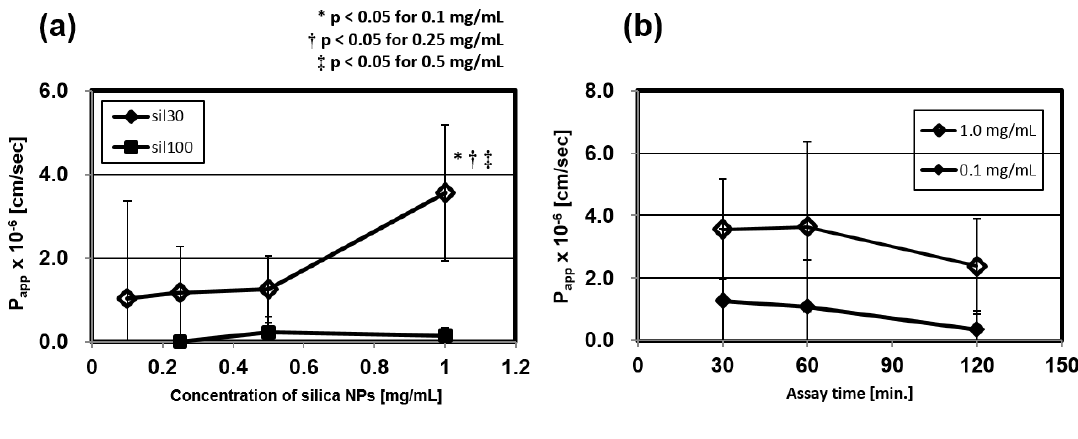
Figure 3. Concentration and time dependent permeability of silica nanoparticles. ( a ) We evaluated the P at four concentrations (0.1, 0.25, 0.5, and 1.0 mg/mL) of the 30 and app 100 nm silica NPs; ( b ) We evaluated the P of the 30 nm silica NPs (0.1 and 1.0 mg/mL) app at three time-courses (30, 60, and 120 min).These values are means ± SD of 6–12